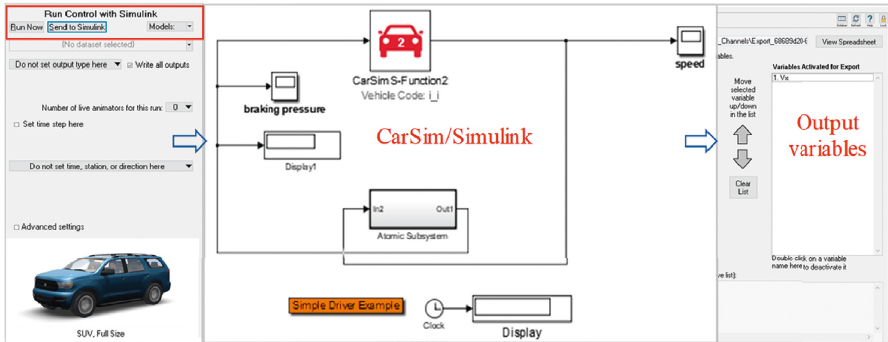
Figure 9: Calculation diagram of CarSim/Simulink cosimulation.